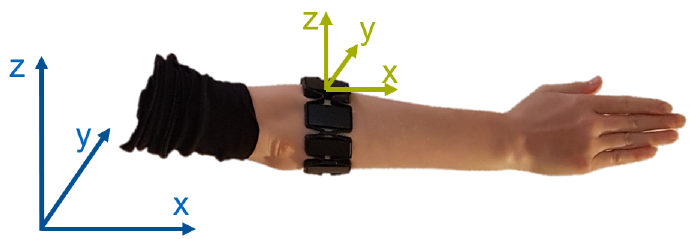
Figure 3. The Myo armband with a local body-fixed coordinate system (green) and global space-fixed reference axes (blue). Linear and angular acceleration are provided relative to the local system. Orien- tation information for quaternions is supplied with reference to the global axes. Euler transformation yields absolute angles in reference to the space-fixed